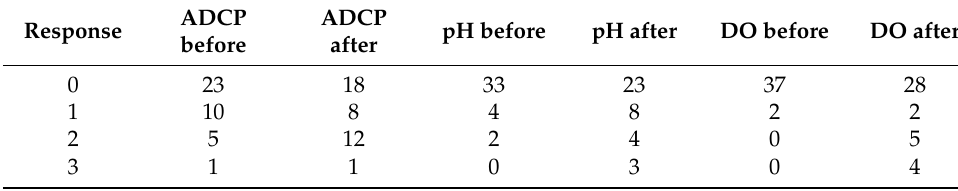
Table 5. Student scored open response assessment (ADCP, pH, and DO).